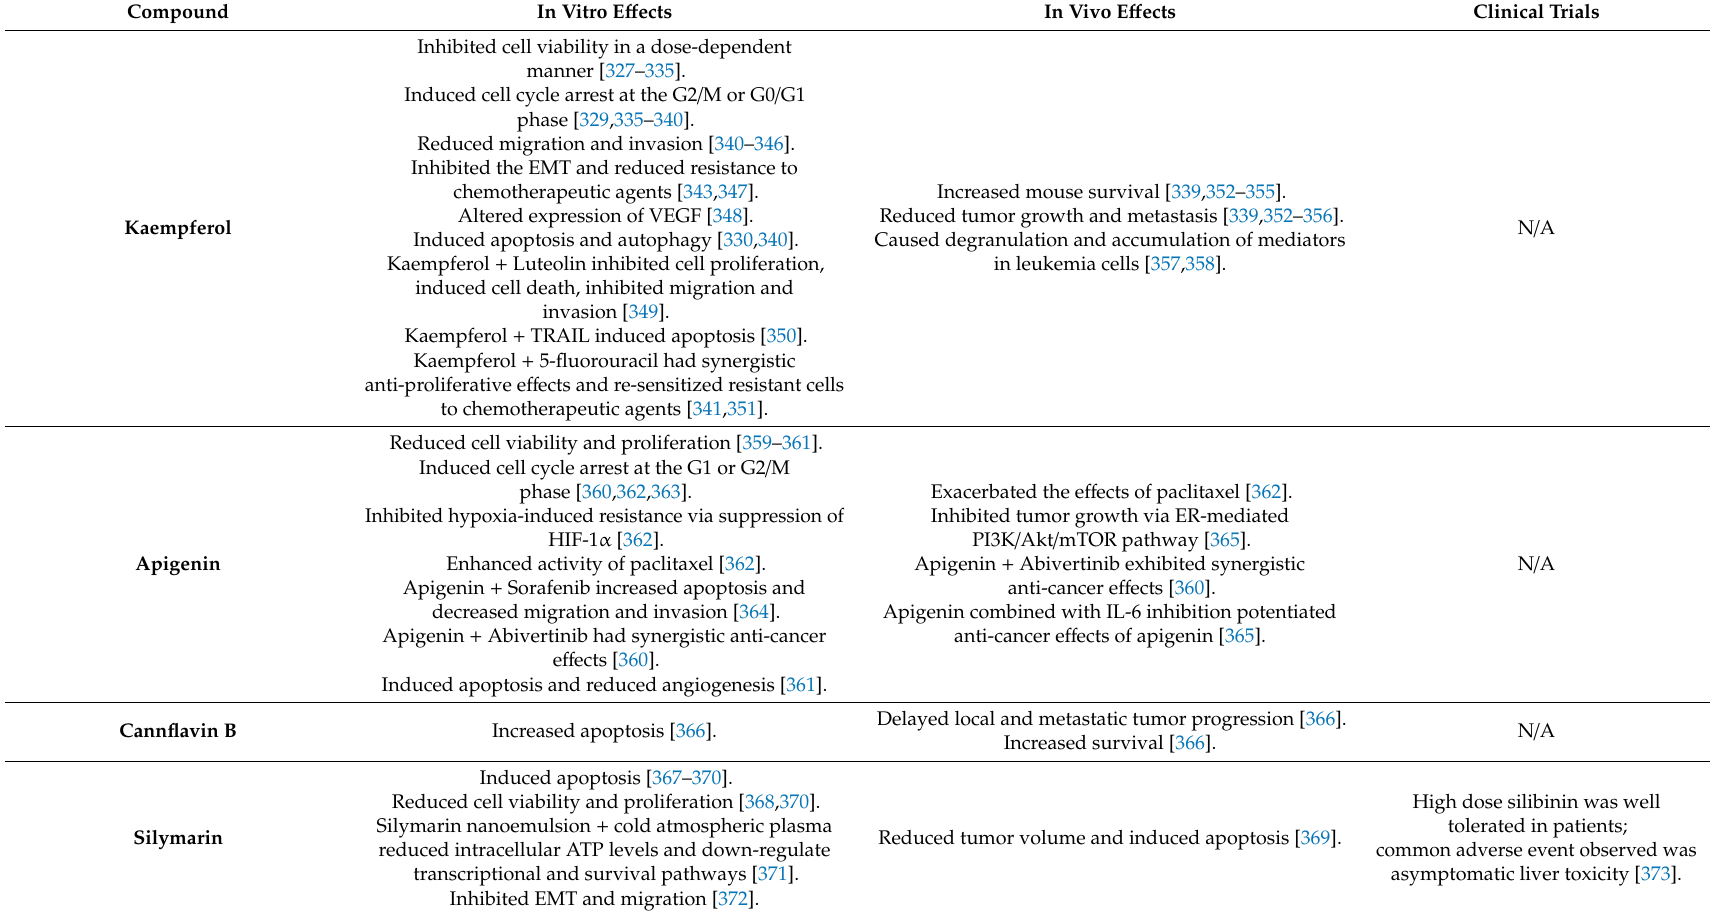
Table 3. Anti-Cancer E ff ects of Flavonoids Present in